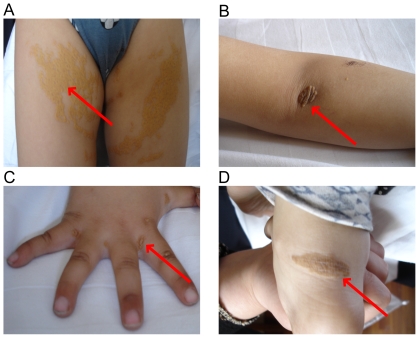
Clinical manifestations of the proband that had a typical FH phenotype (top panel).(A) Cutaneous xanthomas of buttocks, (B) Cutaneous xanthomas on elbow region, (C) Tendinous xanthomas and small cutaneous xanthomas of the hands, (D) Achilles tendon xanthomas.